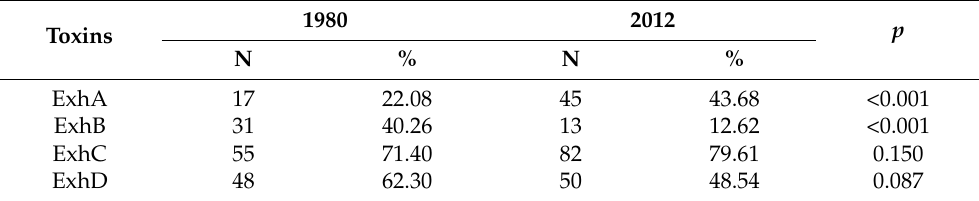
Table 2. Frequency of strains positive for exfoliative toxins in the two periods evaluated (1980s and 2012). 1980 2012 p Toxins N % N % ExhA 17 22.08 43.68 <0.001 ExhB 31 40.26